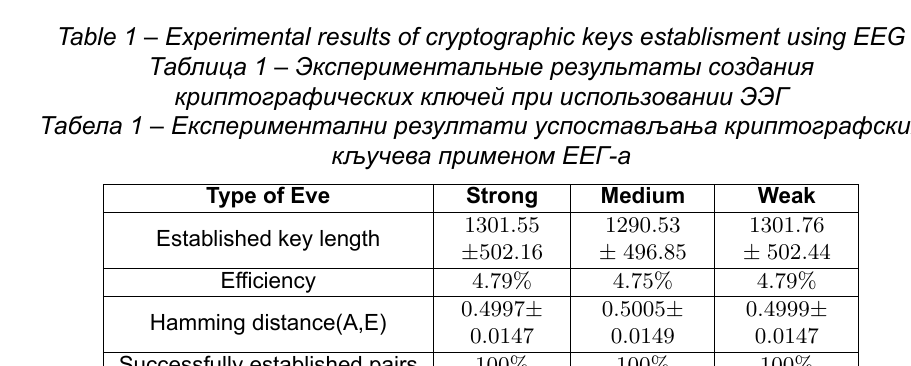
Table 1 – Experimental results of cryptographic keys establisment using